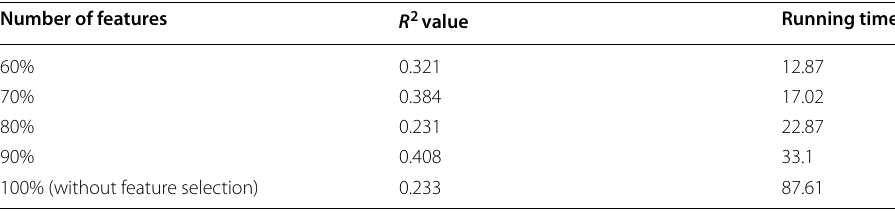
Table 7 QSAR-RFR(SPCA) simulation results on ECFP_6 dataset Number of features